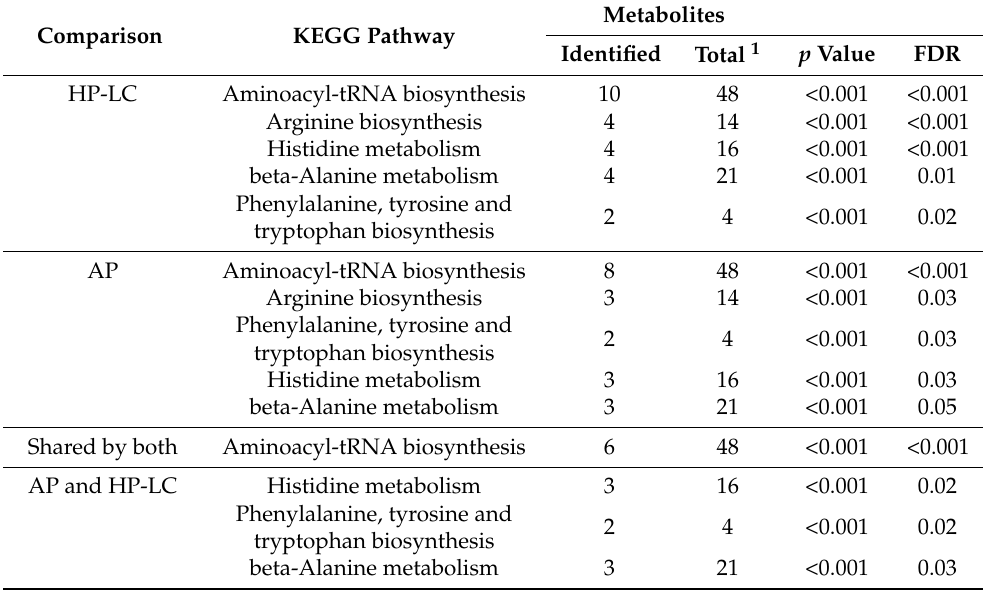
Table 2. KEGG enrichment analyses of differentially abundant metabolites between age class 1 and 80 day porcine offspring exposed to low (LP-HC; 1:10.4), high (HP-LC; 1:1.3) or adequate (AP; 1:5) protein to carbohydrate ratio diets during